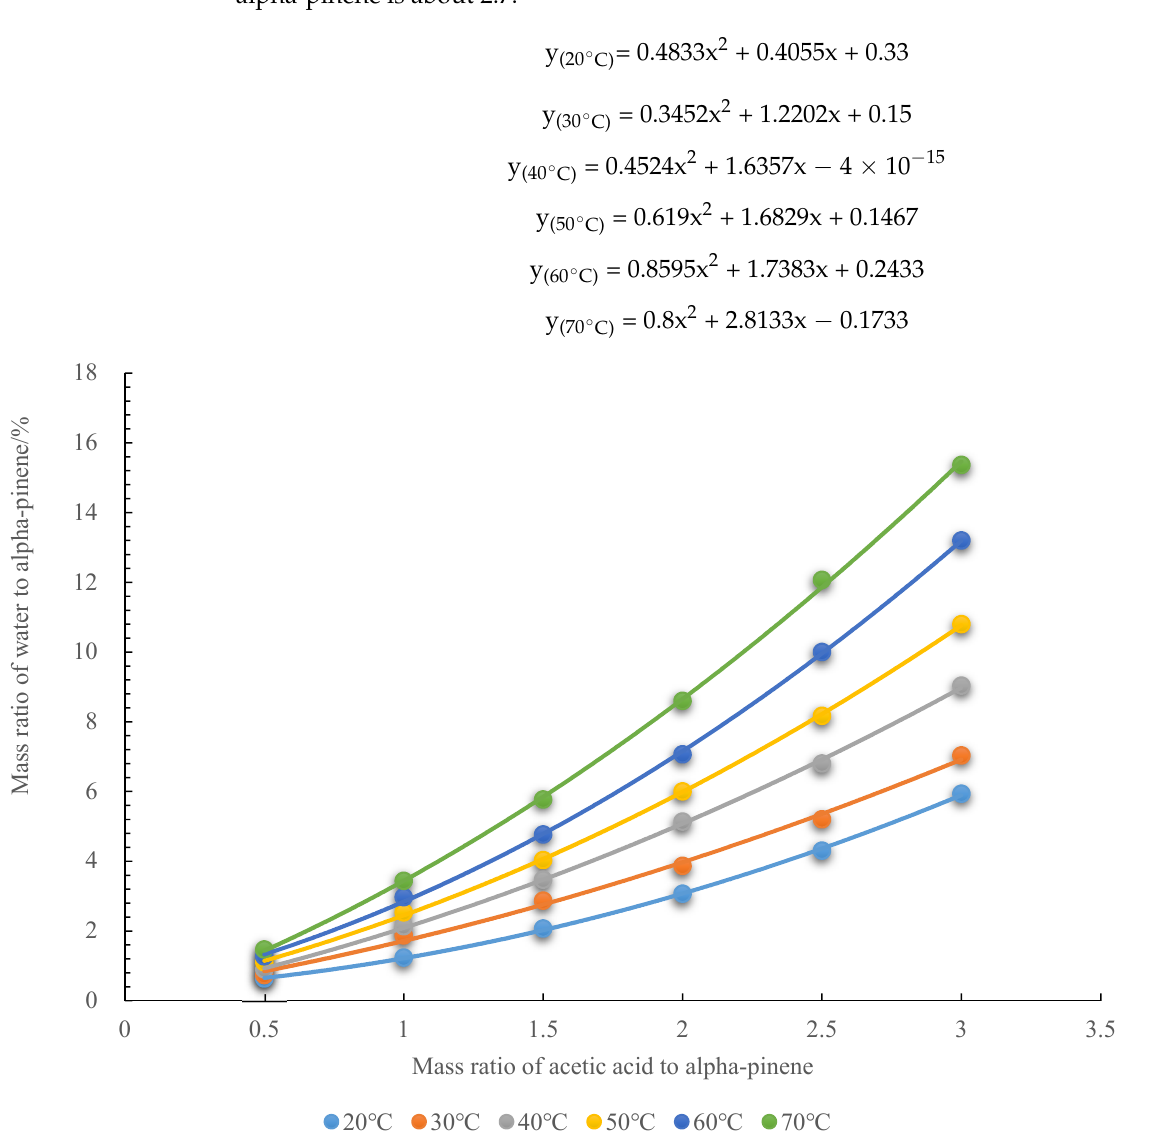
Figure 4. Acetic acid promotes the dissolution of water in alpha-pinene.